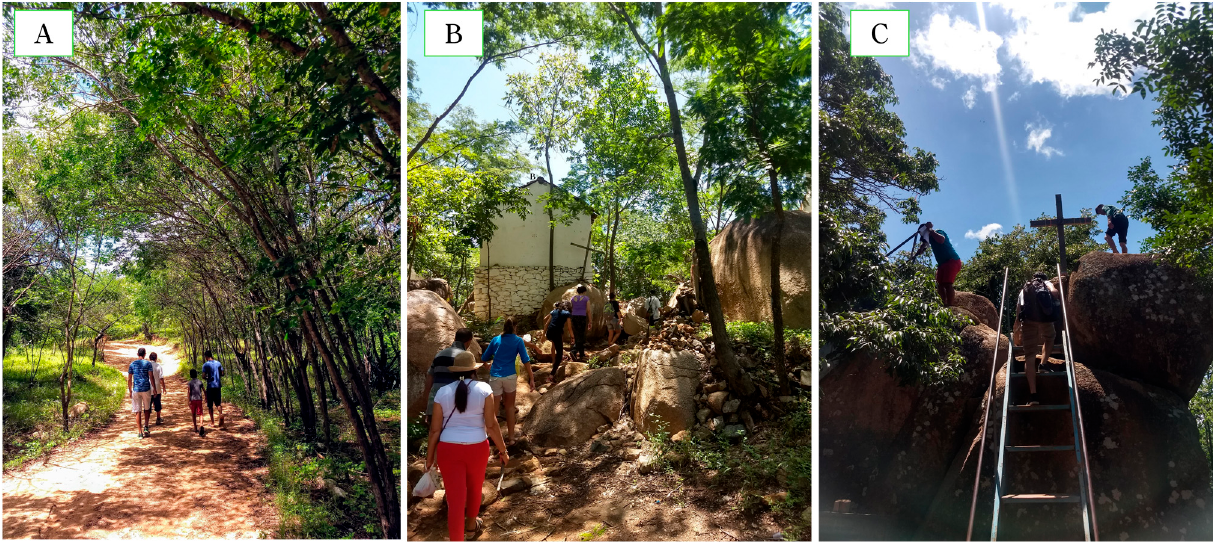
Figure 13. Ground Conditions of the Santo Sepulcro Trail; Araripe UGG. Source: Research Collection. ( A )—Paths with stone pavement; ( B )—Floors with rocky surfaces; ( C )—Viewpoints, characterizing sections as vertical climbs without special material.